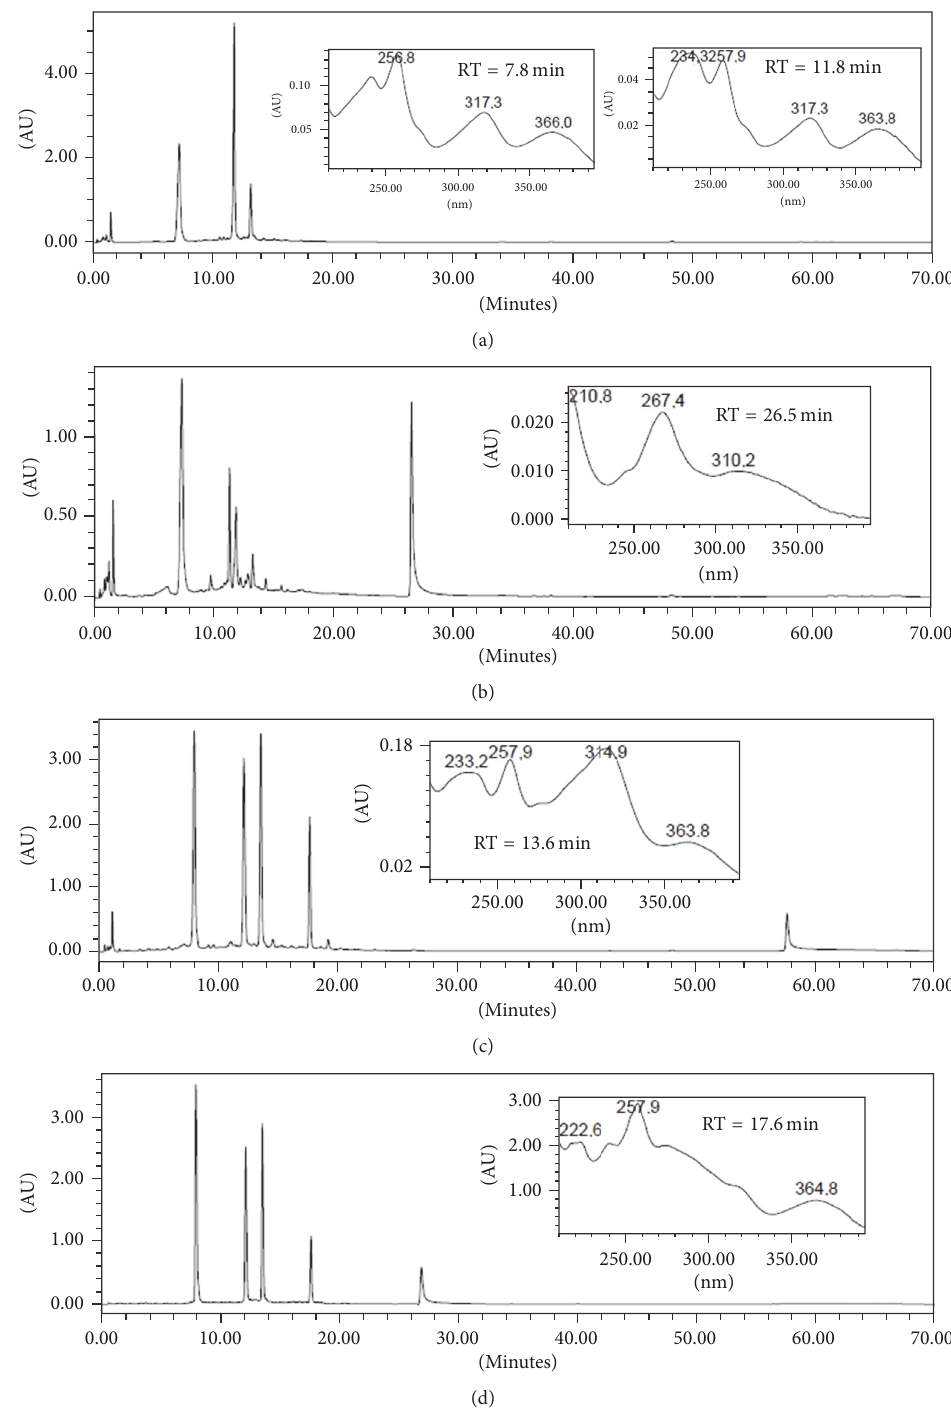
Figure 1: RP-HPLC-DAD fingerprints for the crude ethanol extracts from (a) ethanol extract from Fridericia formosa leaves (EEFFL) with mangiferin (RT = 7.8 min) and 2 󸀠 - O - trans -caffeoylmangiferin (RT = 11.8min) UV spectrum registered online detection 350 nm, (b) ethanol extract from Fridericia formosa stems (EEFFS) with UV spectra registered online for peak corresponding to chrysin (RT = 26.8 min), (c) ethanol extract from Fridericia formosa fruits (EEFFF) with UV spectra registered online for peak corresponding to 2 󸀠 - O- trans- coumaroylmangiferin (RT = 13.6 min), and (d) for a mixture of the isolated compounds with UV spectra registered online for peak corresponding to 2 󸀠 - O - trans- cinnamoylmangiferin (RT = 17.6min). Detection: 350 nm. Chromatographic conditions: see